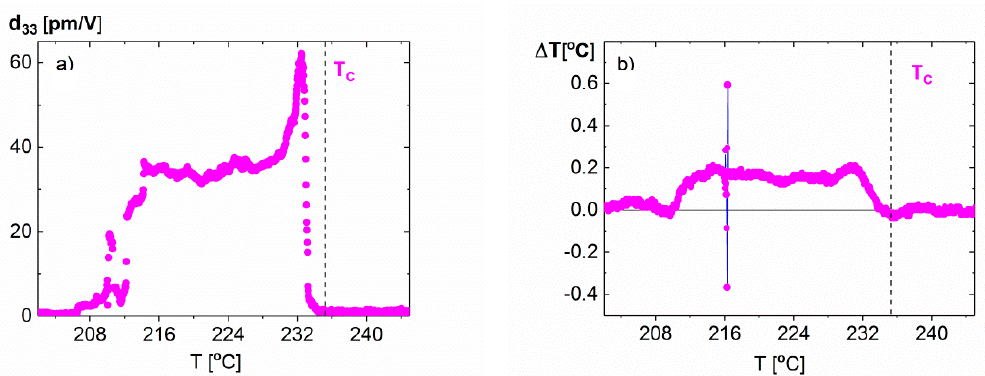
Figure 11. ( a ) Temperature changes of d 33 piezoelectric module and ( b ) changes of sample temperature caused by phase transition enthalpy and/or internal friction caused by movements of domain/polar regions under the influence of an external alternating electric field. The measurement was made on cooling [37].